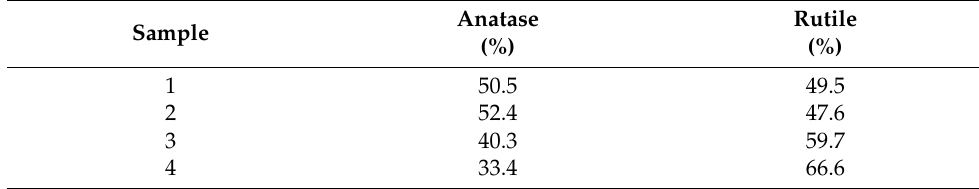
Table 3. The phase composition of samples 1, 2, 3, and